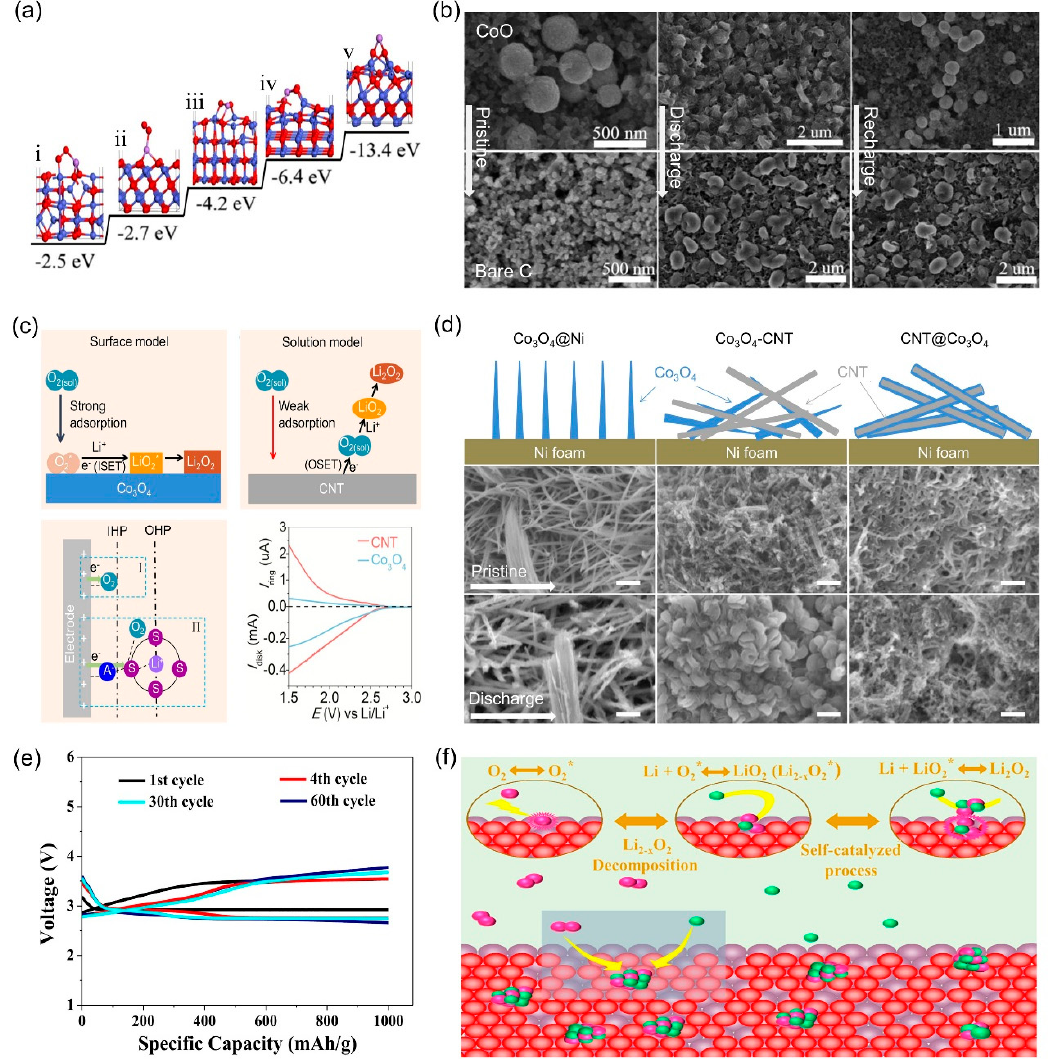
Figure 5. ( a ) The most stable configurations of LiO 2 adsorption on the positive electrode surfaces of ( i ) Co 3 O 4 (110), ( ii ) O-CoO (111), ( iii ) CoO (200), ( iv ) CoO (220), and ( v ) Co-CoO (111). ( b ) The morphology comparison of different positive electrode and their discharge/charge states. ( c ) The illustration of Li 2 O 2 growing on different positive electrode surfaces with varied O 2 adsorption ability and the collected RRDE curves. ( d ) Schematics and SEM images of designed positive electrode materials. ( e ) Discharge/charge voltage profiles of the Li-O 2 batteries with MoO 3 − x positive electrode. ( f ) Schematic diagram of the proposed electrochemical mechanism of the reversible formation of the discharge products on the surface oxygen vacancies of MoO 3 − x positive electrode. ( a,b ) Reproduced with permission from Ref. [97], copyright 2015, Nature Publishing Group. ( c,d ) Reproduced with permission from Ref. [99], copyright 2017, Elsevier. ( e,f ) Reproduced with permission from Ref. [102], copyright 2017, Elsevier.